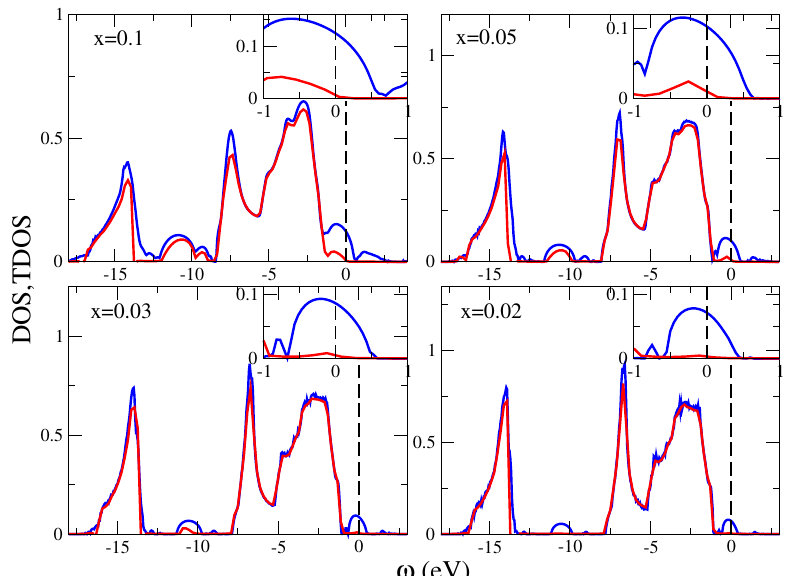
Figure 46. DOS (blue) and typical DOS (red) of Ga 1 0.03, 0.05, 0.1, with N c = 32, showing that the impurity band is completely localized for x The chemical potential is set to be zero and denoted as the dash line. Inset: Zoom in of the DOS and TDOS around the chemical potential. Reprint from